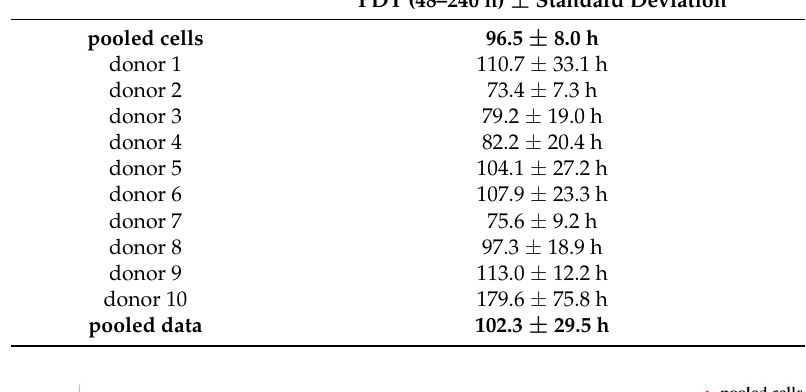
Table A2. Population doubling times (PDT) of ADSCs within an incubation time of 48 to 240 h with special emphasis on the PDT of pooled cells and pooled data (bolded).